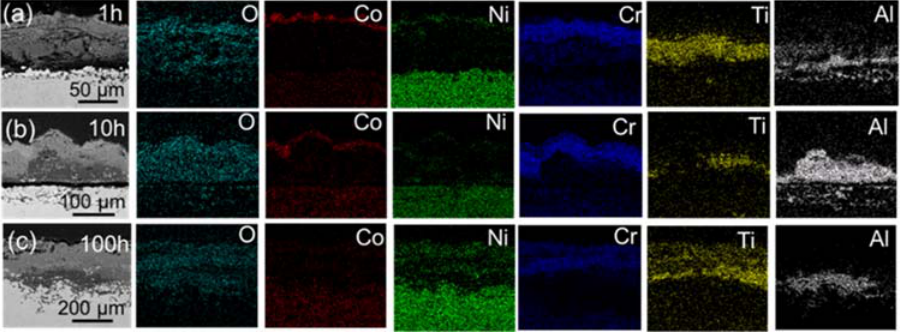
Figure 12. Cross ‐ section morphology and mapping of K452 continuous corroded for 1 h, 10 h, and 100 h with NaCl present. (a) 1h, (b) 10h, and (c) 100h.